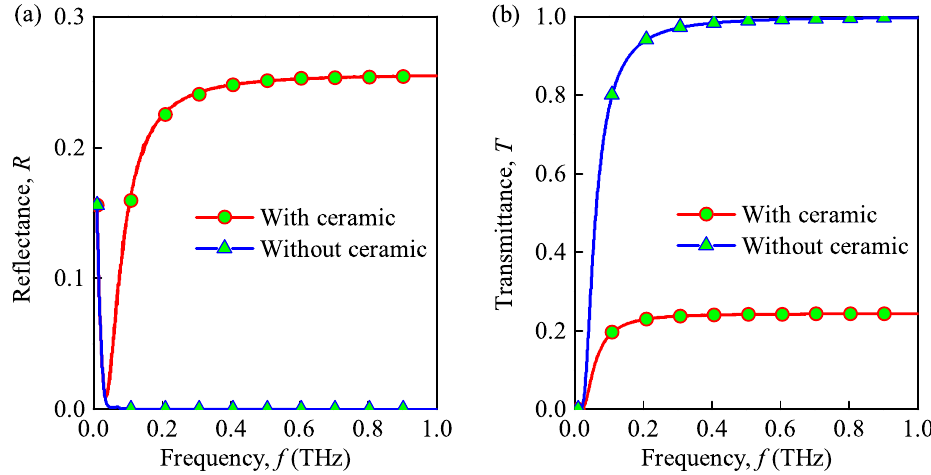
Figure 3. Reflectance ( a ) and transmittance versus ( b ) wave frequency for the case of dusty plasma with and without ceramic